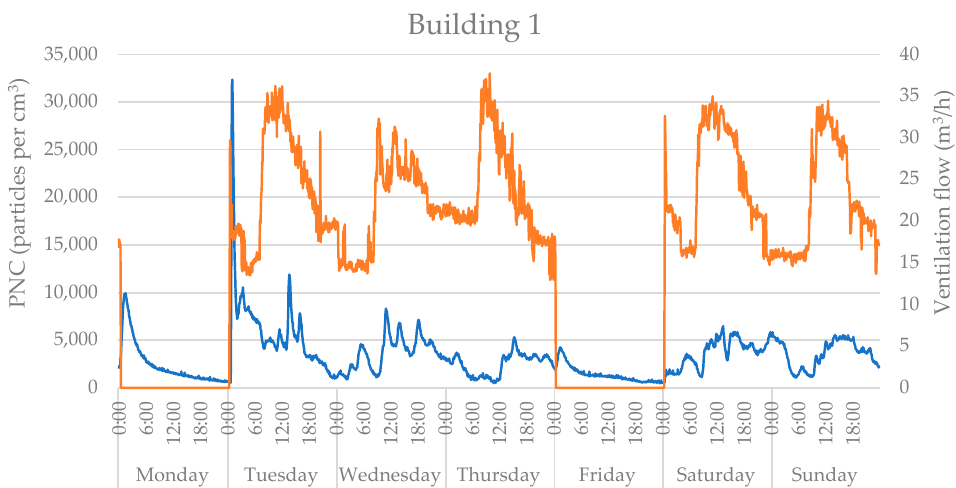
Figure 5. The NP number concentration (blue line) and the ventilation flow (orange line) in Building 1 during the heating season. The NP concentrations and the ventilation flow were measured in five-minute intervals.